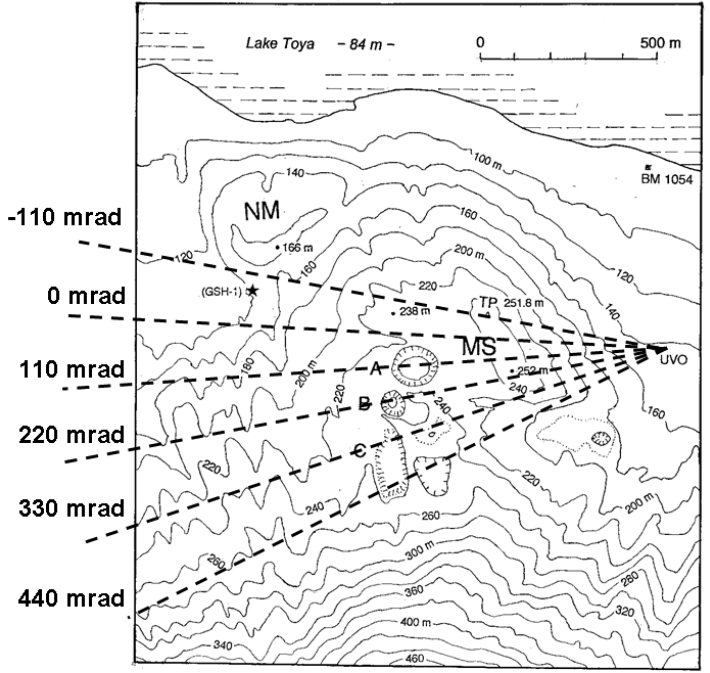
Fig. 5. Topographic sketch map of the MS area as of the year 2000, originally surveyed by the Geographical Survey Institute in the scale of 1/5000. A , B and C denote the craterlets muon radiographically surveyed in the present paper. NM is Nishi-Maruyama, unknown its origin.